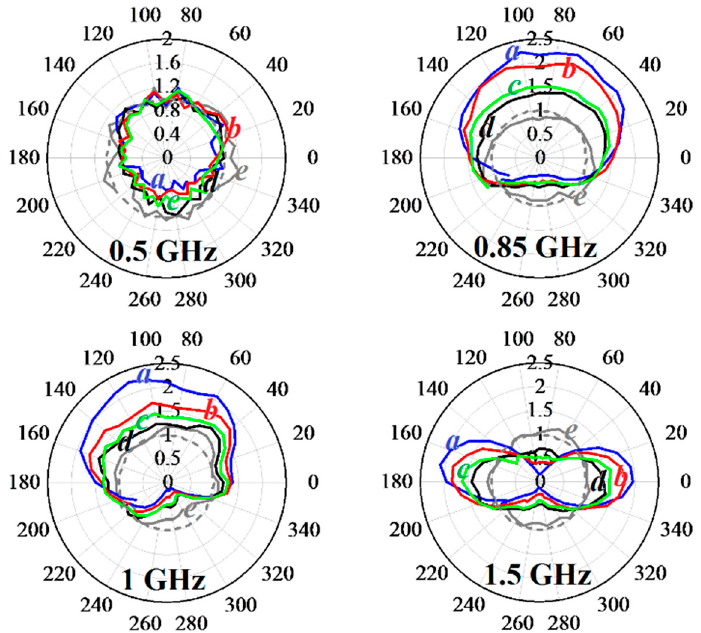
Figure 4. Radiation patterns for the first lamp configuration at different frequencies and discharge current values: a (blue curves) 200 mA; b (red curves)—100 mA; c (green curves)—50 mA; d (black curves)—35 mA; e (gray solid curves)—free linear antenna (no discharge).